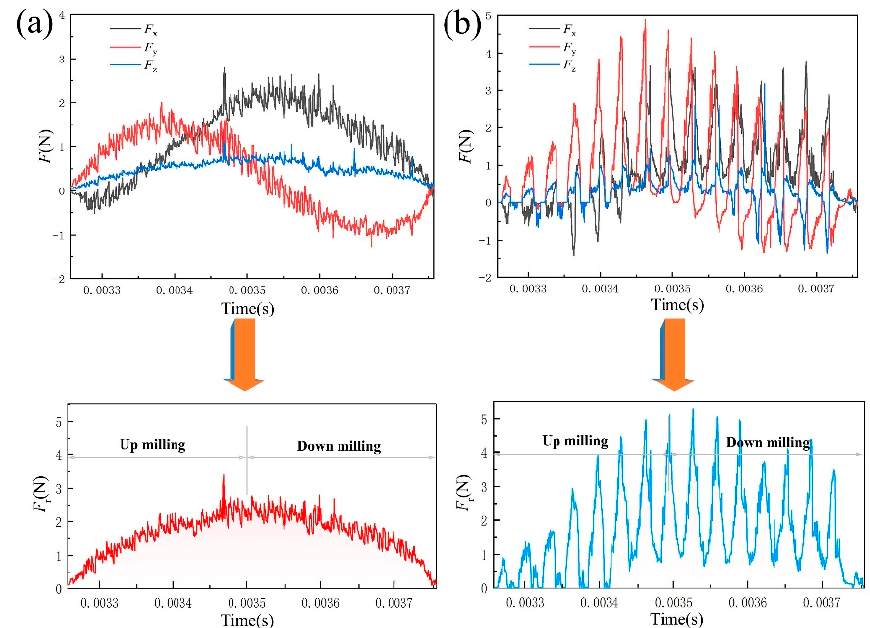
Figure 6. Cutting force changes in a single cutting cycle ( a ) TMM; ( b ) UVAMM.